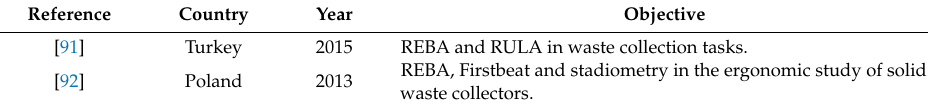
Table 7. Water supply; sewerage, waste management and remediation activities.